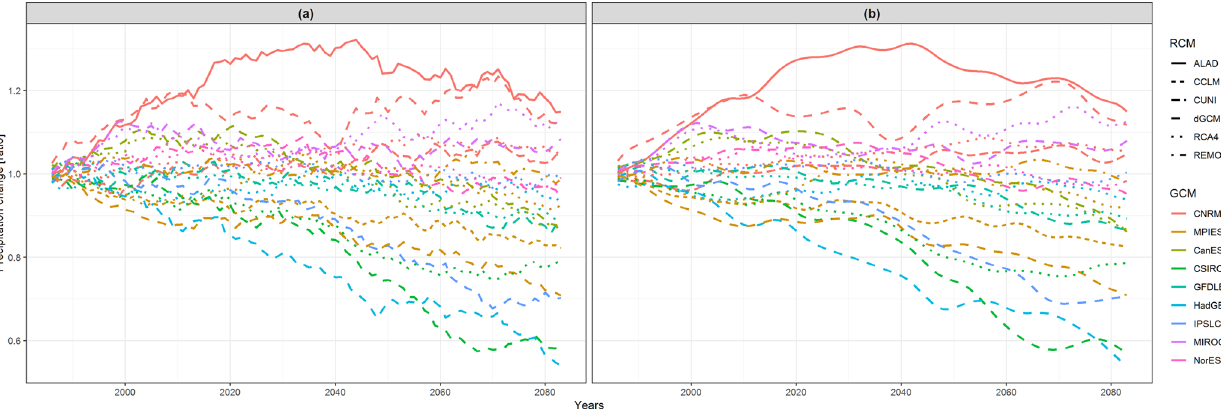
Figure 2. The same as Fig. 1, but for running 30-year mean changes in summer (JJA) mean precipitation (relative changes of running 30- year mean averages throughout the period 1971–2098 in comparison to the reference period 1971–2000), averaged over the eastern European